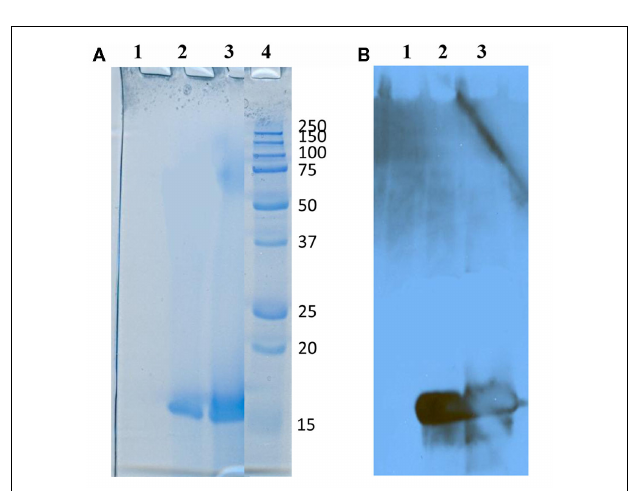
FIGURE 7 | Secretion of overexpressed Cu/Zn SOD by RB51SOD but not by RB51. Bacterial supernatants of 10ml cultures were precipitated by TCA, processed by SDS-PAGE, and stained with Coomassie brilliant blue (A) or subjected toWestern blot analysis (B) . Lane 1, RB51 culture supernatant; lane 2, RB51SOD culture supernatant; lane 3, authentic Brucella Cu/Zn SOD; and lane 4, molecular weight markers.The Cu/Zn SOD protein band observed had a molecular mass approximating